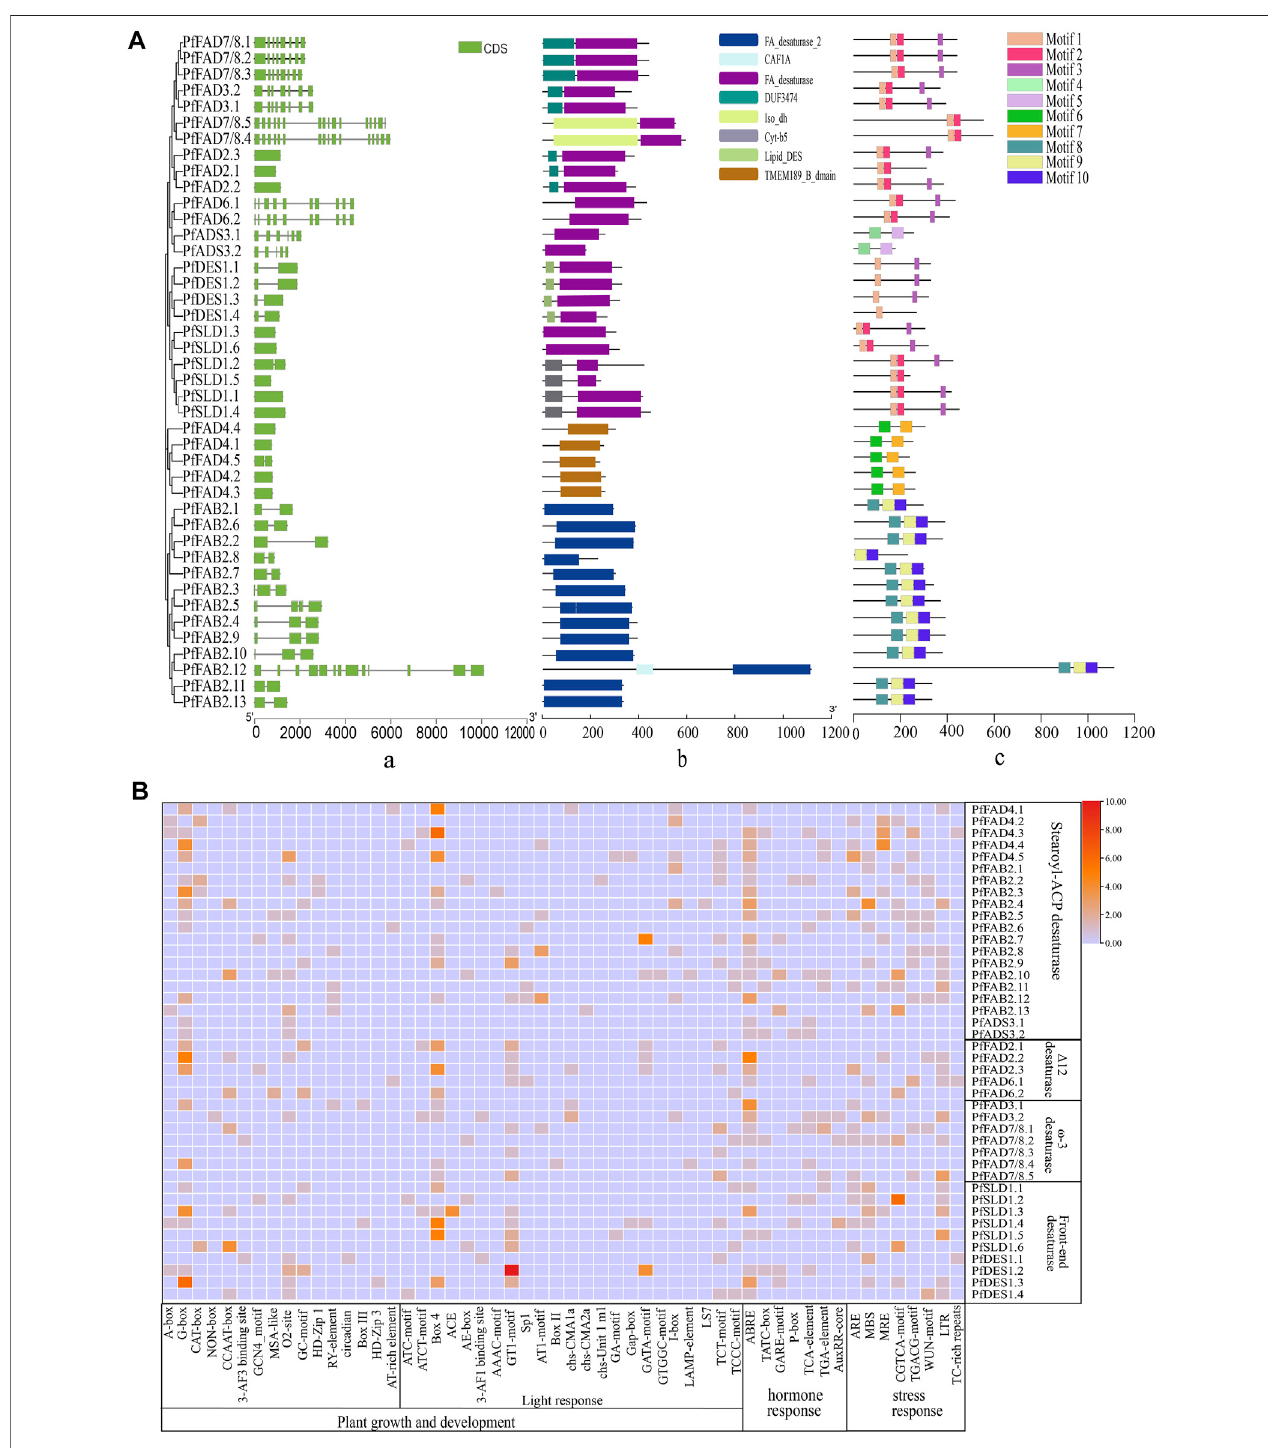
FIGURE 2 | Structure and cis-acting elements of FADs in perilla. (A) Analysis of gene structures (i) , domains (ii) , and motifs (iii) of the PfFADs. Introns/exons were identi fi edusingtheGSDStool.ConserveddomainsandmotifswereanalyzedusingPfamandMEME. (B) Analysisofthecis-actingelementsinthepromotersof PfFADs . The cis-acting regulatory elements in the upstream 2,000-bp sequences of the genes were identi fi ed using the PlantCARE website. Orange and red shading indicates the number of cis-acting elements present; light blue shading means no cis-acting elements were present.